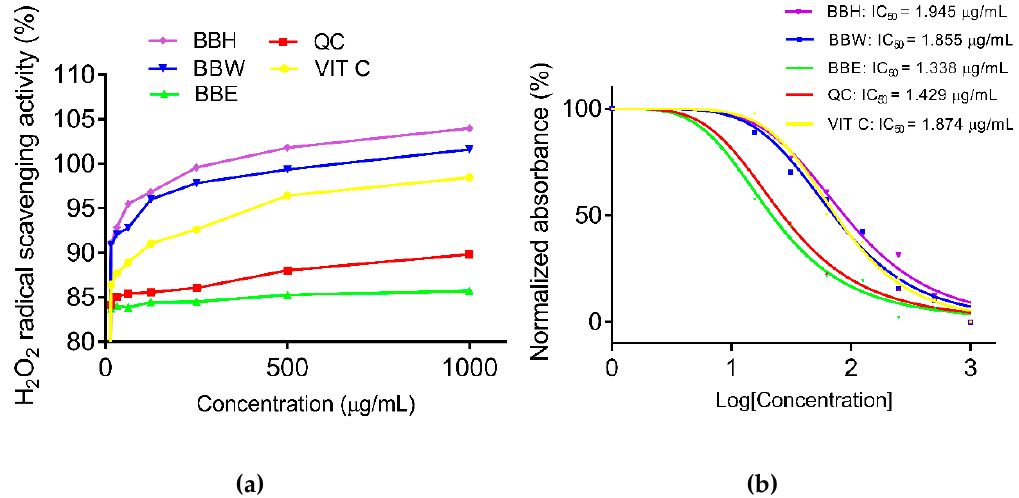
Figure 2. H 2 O 2 scavenging activity ( a ) and normalized absorbance of H 2 O 2 ( b ). H 2 O 2 : hydrogen peroxide, BBE: bee bread